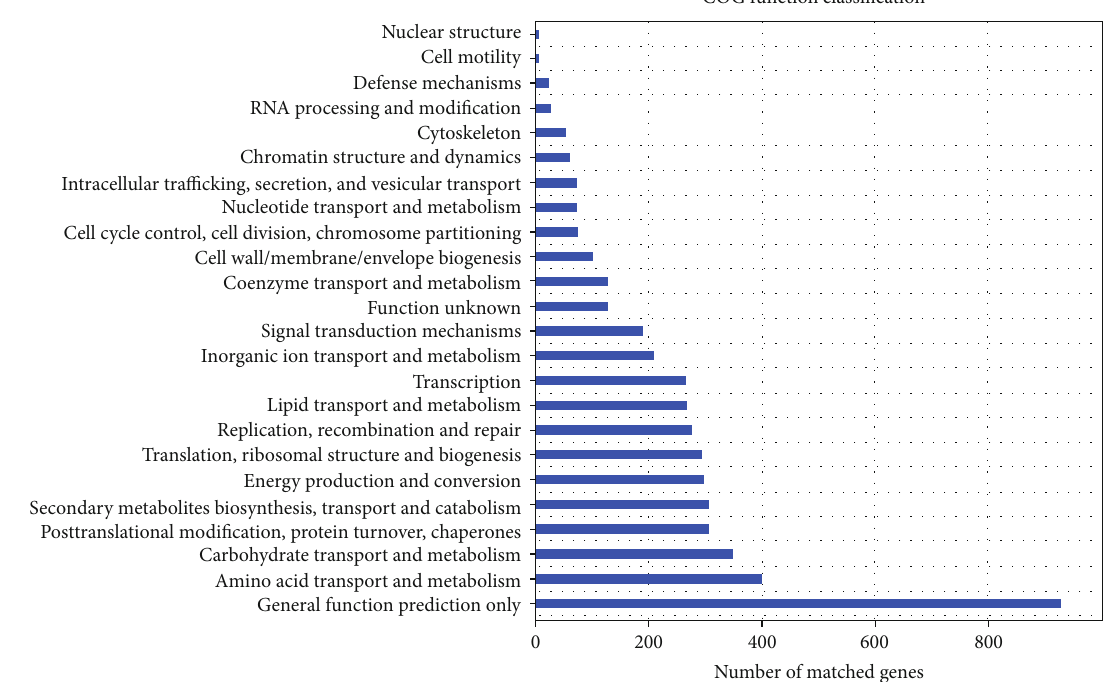
Figure 4: Clusters of orthologous groups (COG) of protein annotations of genome. X -axis, COG categories; Y -axis, number of matched genes. Total number of genes enriched in KEGG pathways was 1,311.